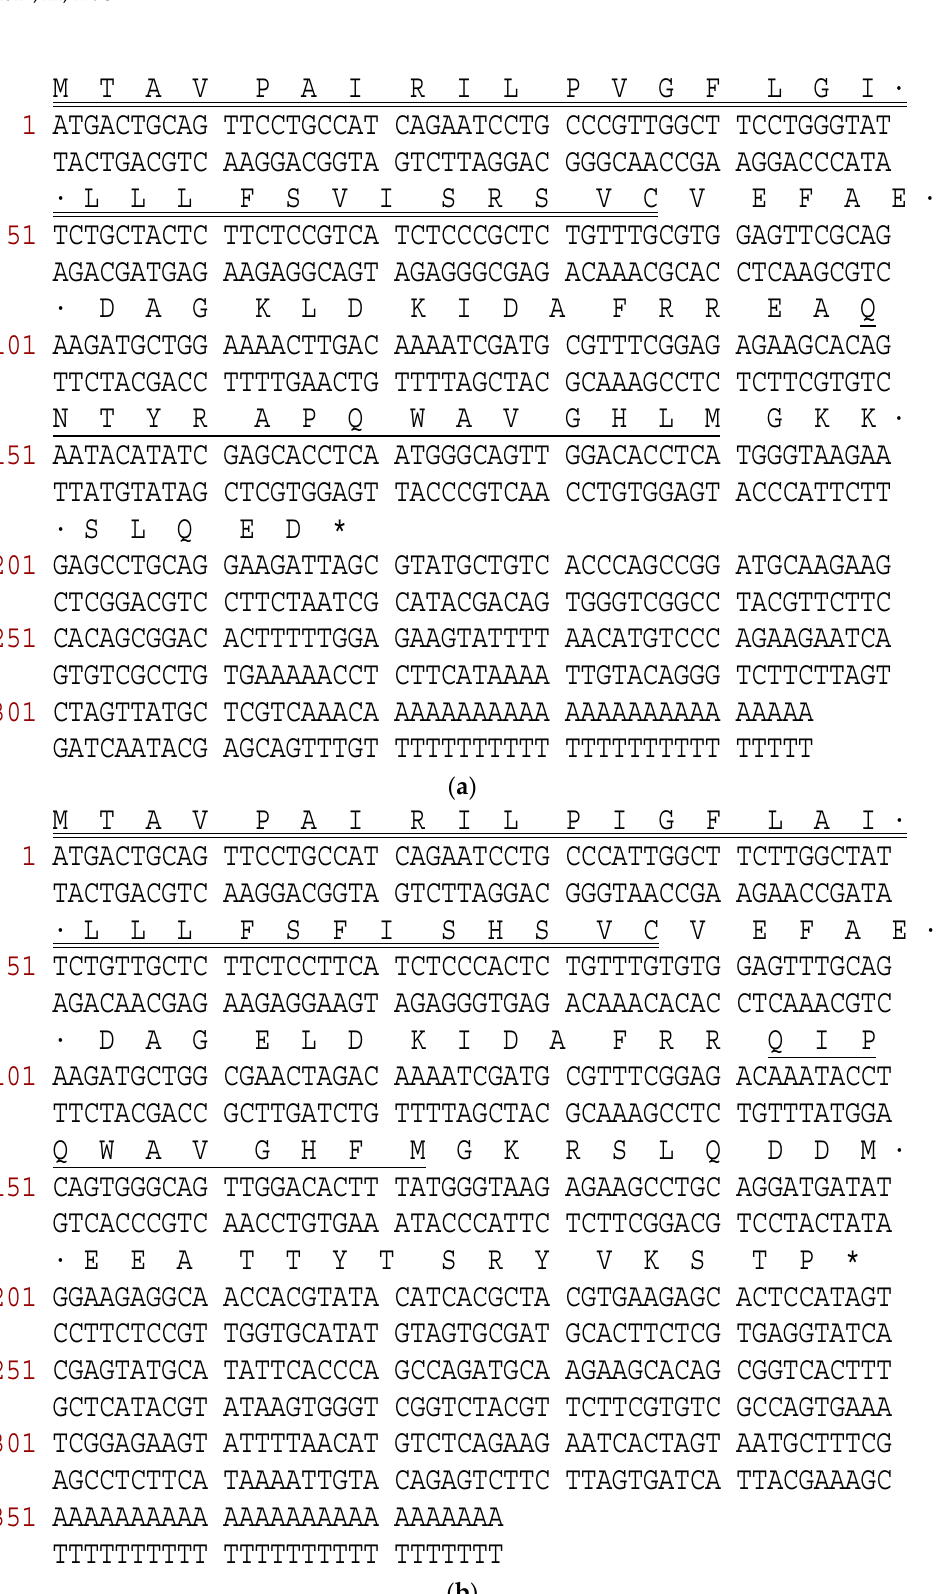
Figure 1. The sequences of cDNAs encoding bombesin-OS and bombesin-PE precursors. ( a ) Nucleotide and corresponding translated open-reading frame amino acid sequence of precursor cDNA cloned from the Chinese piebald odorous frog cDNA encoding bombesin-OS; ( b ) Nucleotide and corresponding translated open-reading frame amino acid sequence of precursor cDNA cloned from the skin secretion of European edible frog cDNA encoding bombesin-PE. Putative signal peptides are double-underlined, mature peptides are single-underlined and stop codons are marked by asterisks.